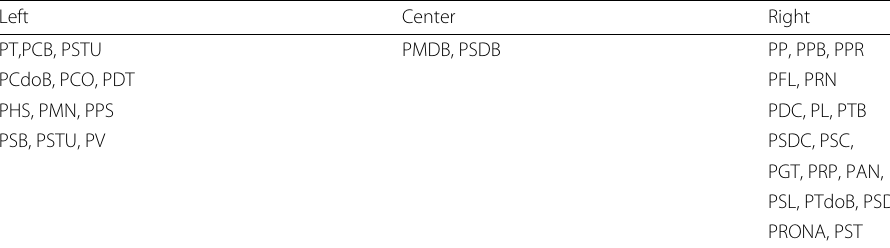
PGT, PRP, PAN, PSL, PTdoB, PSD, PRONA,